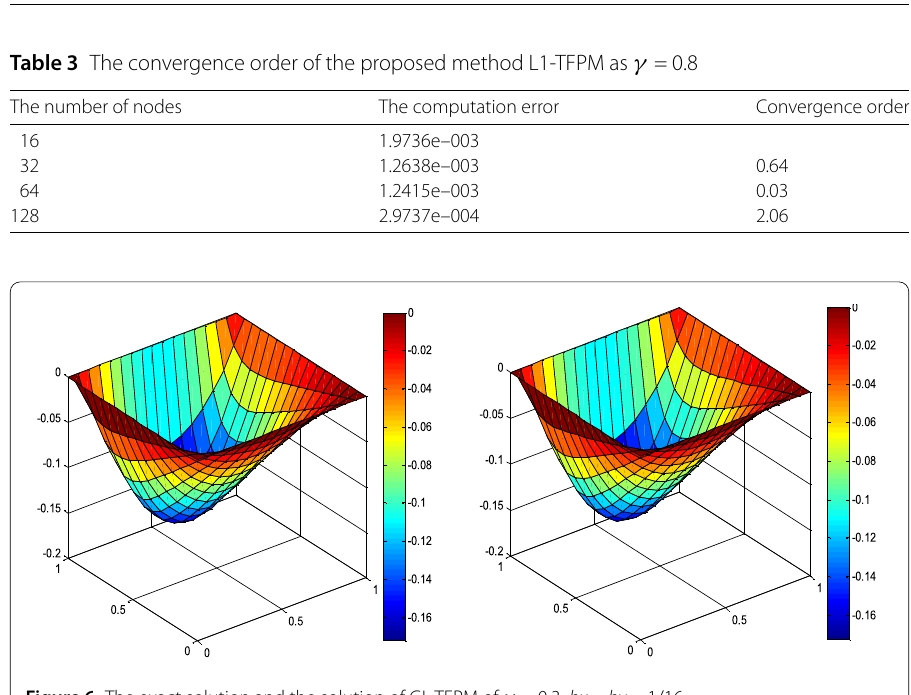
Figure 6 The exact solution and the solution of GL-TFPM of γ = 0.3, hx = hy = 1/16